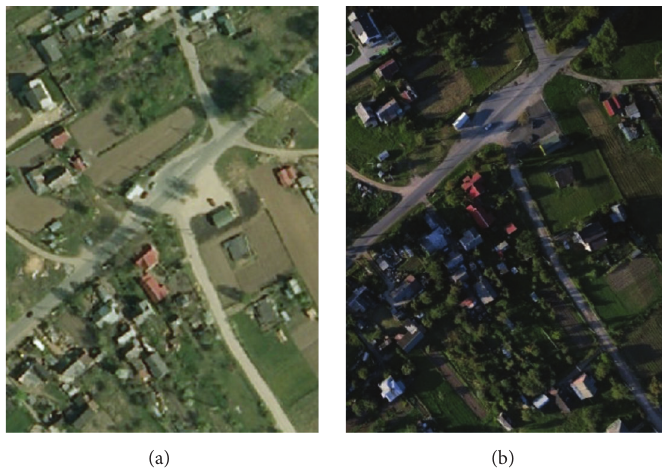
Figure 8: Orthophoto images ((a) in 2009; (b) in 2012 compiled by the authors).